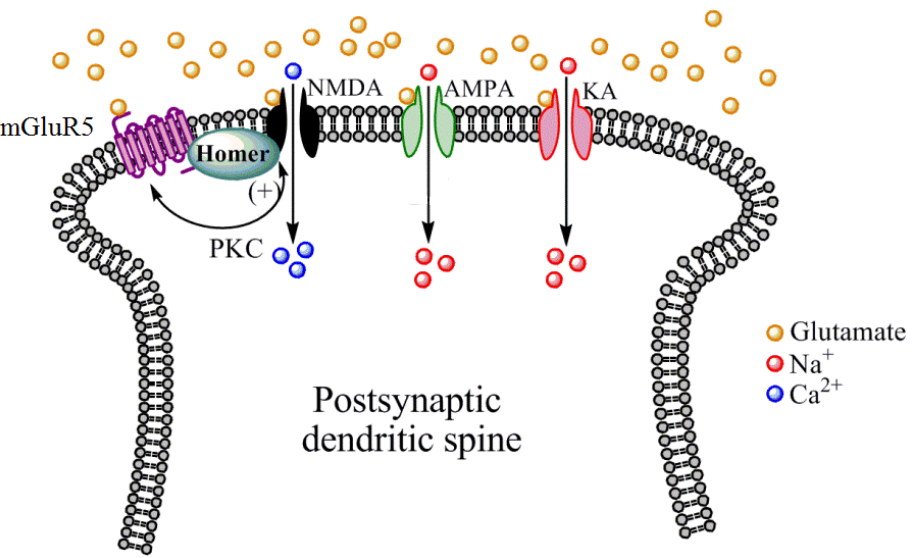
Figure 3. Mechanisms by which mGluR5 receptors indirectly modulate NMDA receptor function. Located primarily postsynaptically on dendritic spines, mGluR5 receptors are structurally linked to NMDA receptors by numerous scaffolding proteins including Homer proteins. Protein kinase C (PKC), which is activated by mGluR5 receptor stimulation, phosphorylates NMDA receptors to increase the cationic conductance of this receptor. PKC can also phosphorylate mGluR5 receptors to modulate their function. Other iGluR subtypes such as AMPA and KA do not appear to share this biochemical and structural linkage with mGluR5